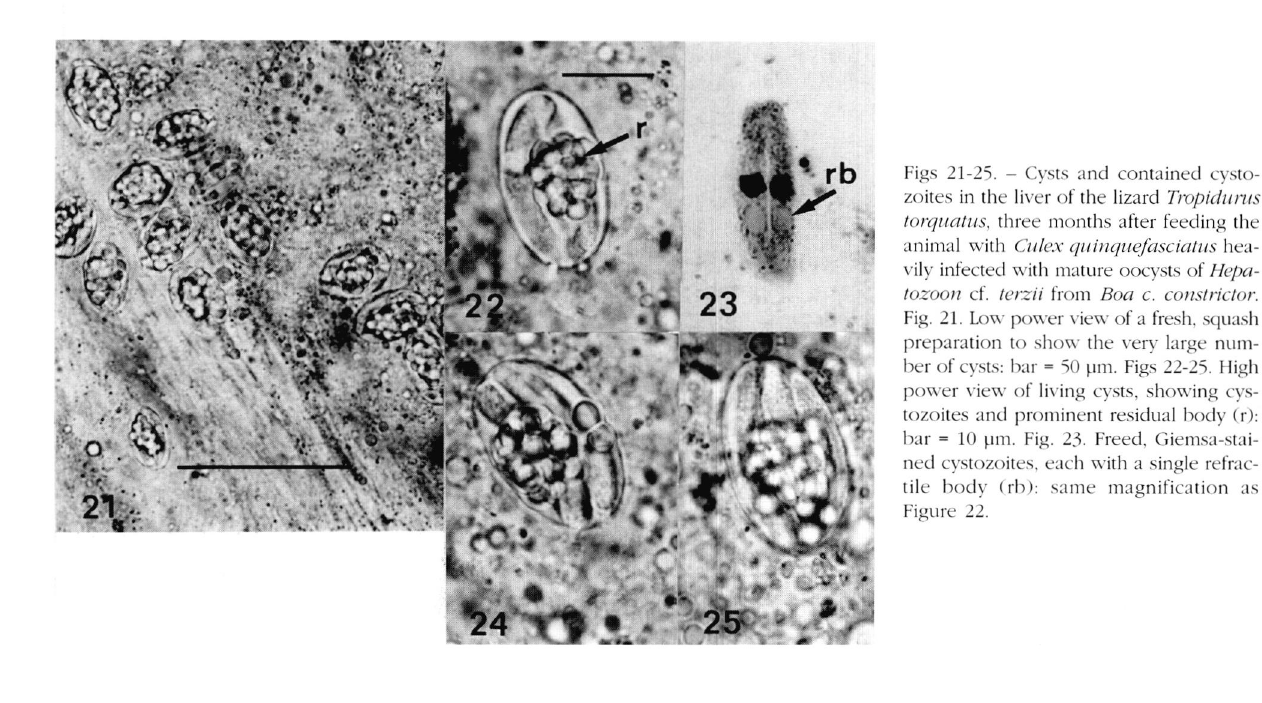
Figs 21-25. - Cysts and contained cysto zoites in the liver of the lizard Tropidurus torquatus, three months after feeding the animal with Culex quinquefasciatus tozoon cf. terzii from Boa c. constrictor. Fig. 21. Low power view of a fresh, squash preparation to show the very large num ber of cysts: bar = 50 µm. Figs 22-25. High power view of living cysts, showing cys tozoites and prominent residual body (r): bar = 10 pm. Fig. 23. Freed. Giemsa-stai- ned cystozoites, each with a single retrac tile body (rb): same magnification as Figure